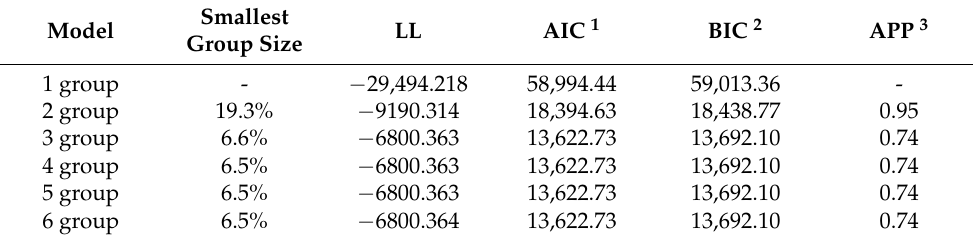
Table 3. The goodness of fit of group-based trajectory analysis sample